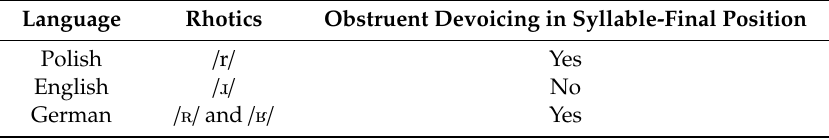
Table 2. Selected features under analysis in the present